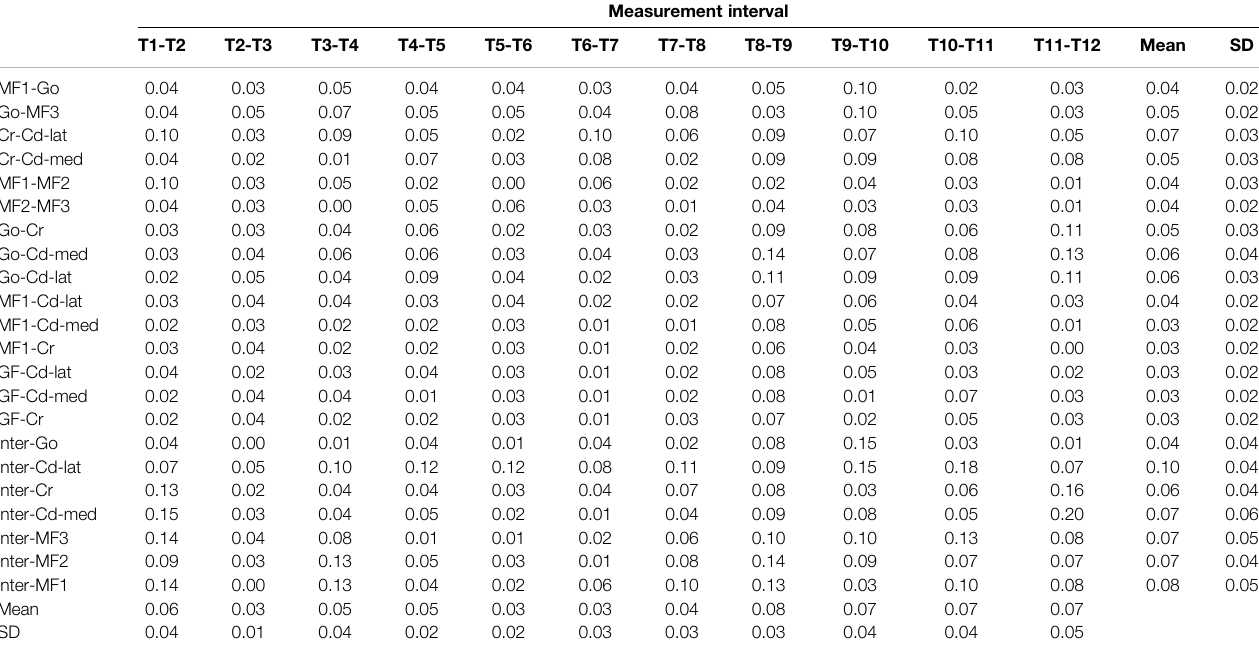
TABLE3| Rootmeansquareerrors(RMSE)ofthemonthlygrowthratesbetweenthenewmethodandthegoldstandardacrossallsubjectsforlandmarkpairscalculatedas theinter-markerlengthchangesbetweentwoconsecutiveinstancesnormalizedtothecorrespondinglengthattheproceeding instance overthemonitoringperiod.( n = 8; unit: